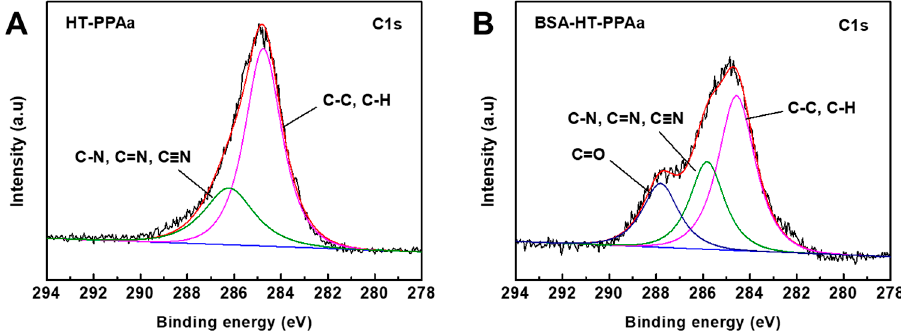
Figure 7. High-resolution survey of ( A ) HT-PPAa film and ( B ) BSA-HT-PPAa film on